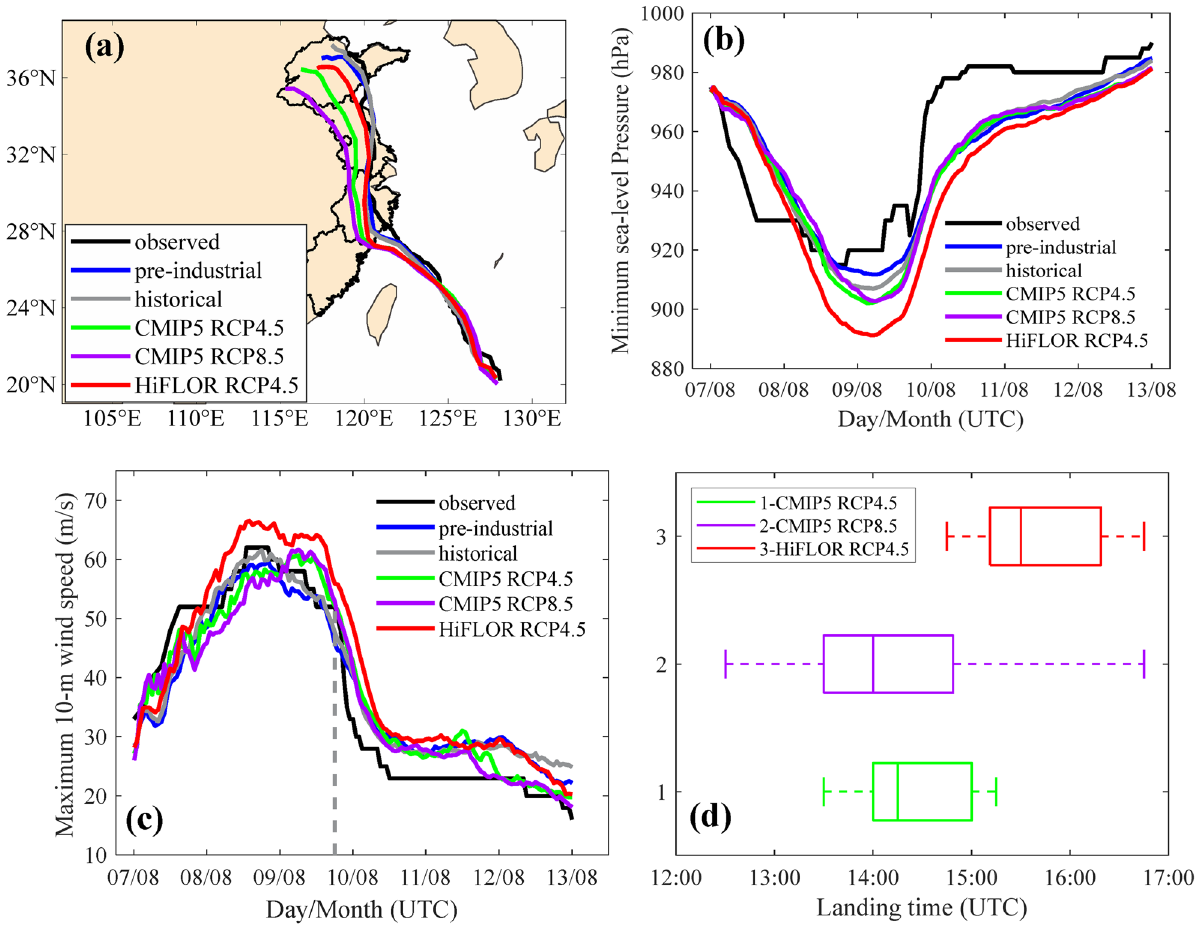
Figure 2. Tracks, time series of minimum SLP, time series of maximum 10-m wind speed, and landing time for Typhoon Lekima. ( a – c ) Observations (black), ensemble mean of the pre-industrial (blue), historical (gray), RCP4.5 of HiFLOR (red), RCP4.5 (green), and 8.5 (purple) of CMIP5 mean simulations at 4-km resolution for Typhoon Lekima. ( a ) Tracks. ( b ) The time series of minimum SLP (hPa). ( c ) Maximum 10-m wind speed. Observed landfall time is marked with a vertical gray dashed line. (d) TC landing time in boxplot for the ensemble simulation under three future PGW conditions . Maps were generatedbyMATLABR2021a(http:// www. mathw orks.